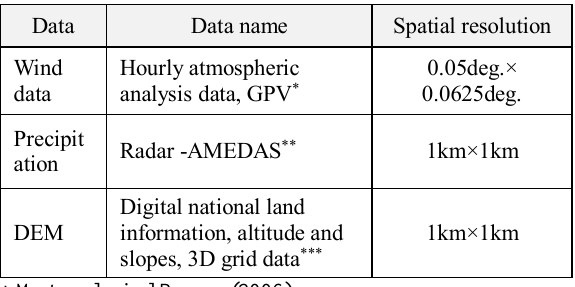
Table 1. Used data for calculation